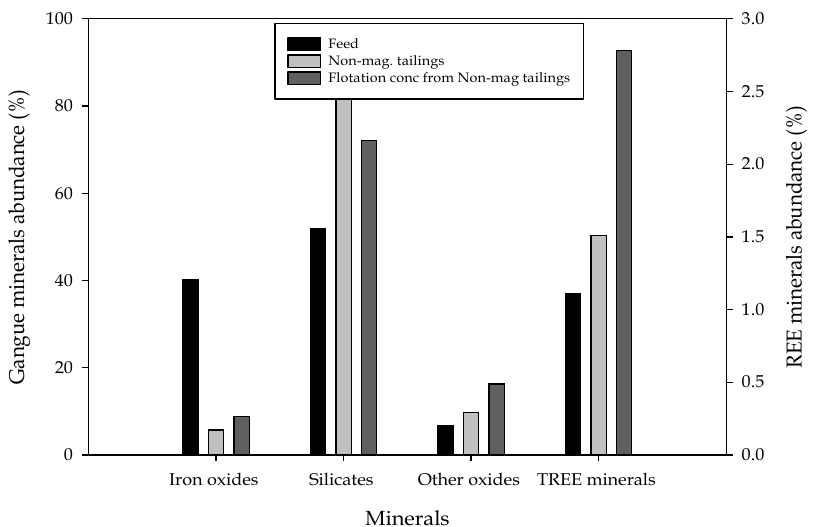
Figure 9. Mineral mass abundance of TREE and gangue minerals in the feed, non-magnetic tailings, and flotation concentrate from non-magnetic tailings using hydroxamic acid.